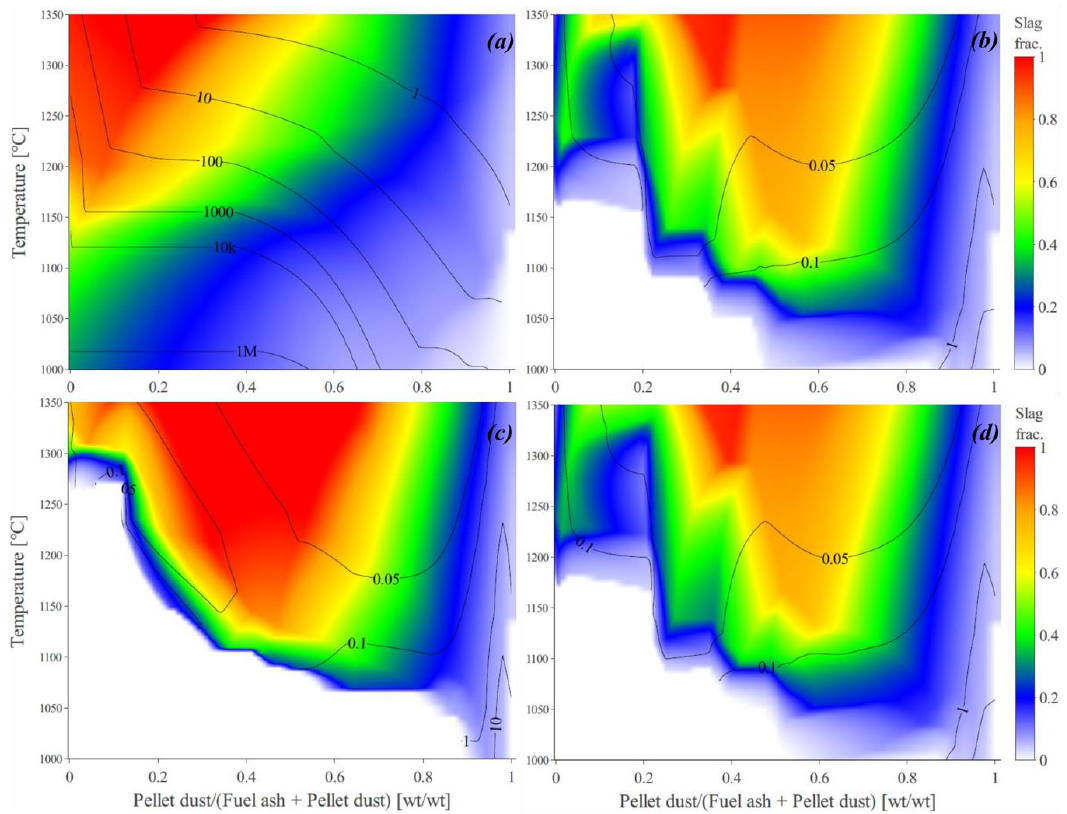
Figure 3. Mass fraction of the molten slag (melt) in the condensed phases (solid + liquid) predicted for ( a ) coal; ( b ) raw stem wood; ( c ) stem wood-pyrolysis oil; ( d ) stem wood-biochar, together with the estimated viscosity of the corresponding melt from 1000 to 1350 °C. Contours of viscosities are in Pa.s.